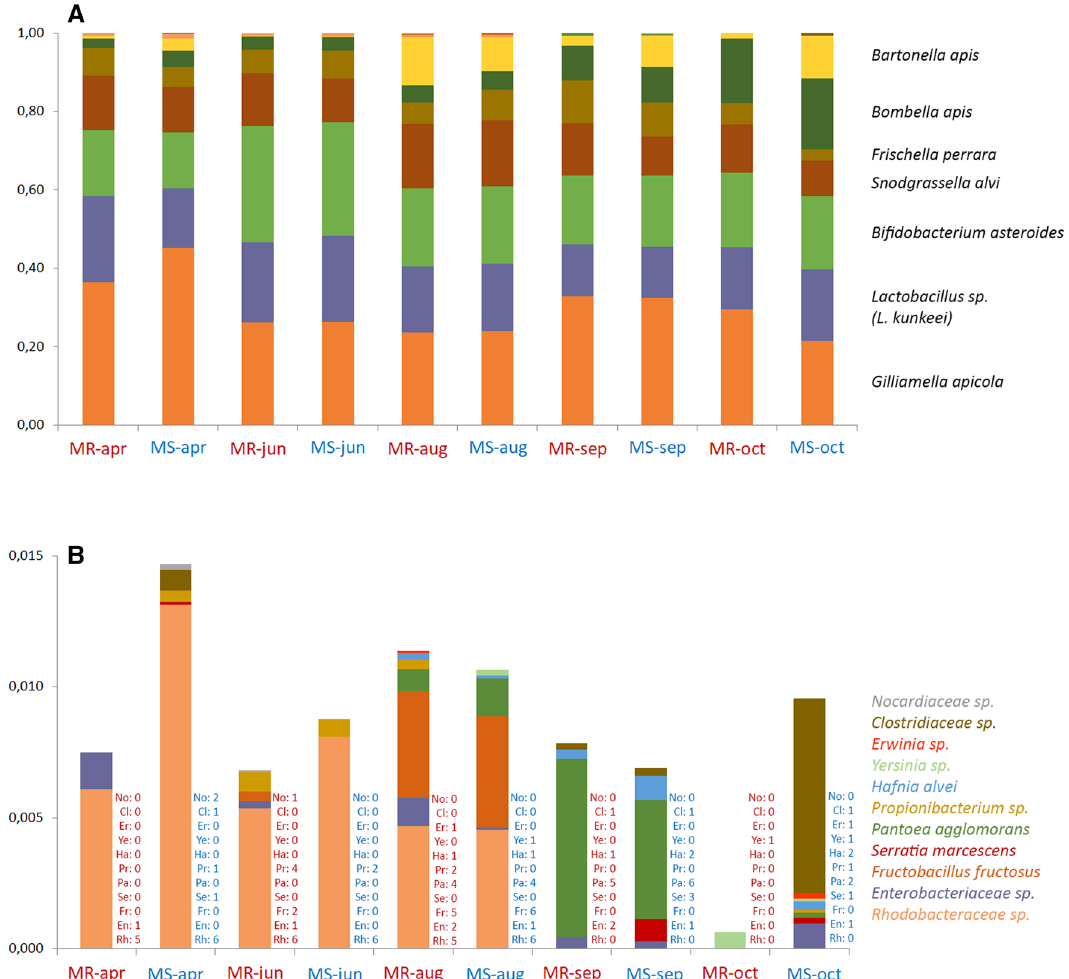
Figure 1. Bacterial community composition. Distribution of the most common bacterial OTUs in the MR and MS colonies during the 2015 season. Each bar represents the mean relative abundance of reads from the 16S rRNA V2 hypervariable region assigned to different bacterial OTUs, averaged over the six colonies in each of the MR (red) and MS (blue) genetic groups. ( A ) Displays the full bacterial composition, including both core and minor taxa, with the names of the most abundant taxa shown beside their stacked segment. ( B ) Highlights the relative contribution of just the 11 minor taxa, accounting for < 1.5% of the total bacterial compositiion. The numbers beside each stacked histogram indicate how many of the six colonies in the MR or MS groups contributed reads for each of the minor taxa (identified by their first two letters) while the legend shows the bacterial taxa in the order in which they are stacked in the histogram, identified by